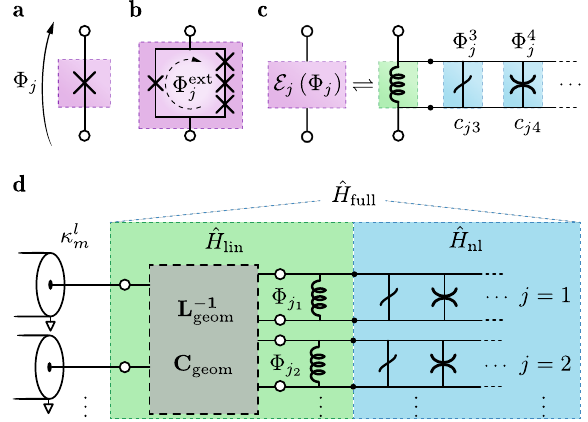
Fig. 3 Schematic representation of the Josephson circuit and its nonlinear elements. a A simple example of a Josephson dipole — a Josephson tunnel junction. b An example of a composite junction, comprising four Josephson junctions in a ring, frustrated by an external magnetic fl ux Φ ext